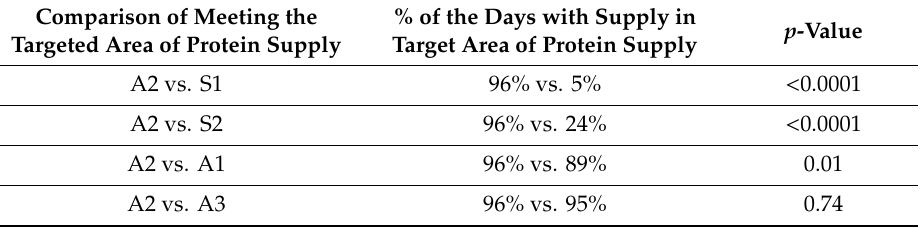
Table 5. Comparison of di ff erent protein supplementation strategies in the validation